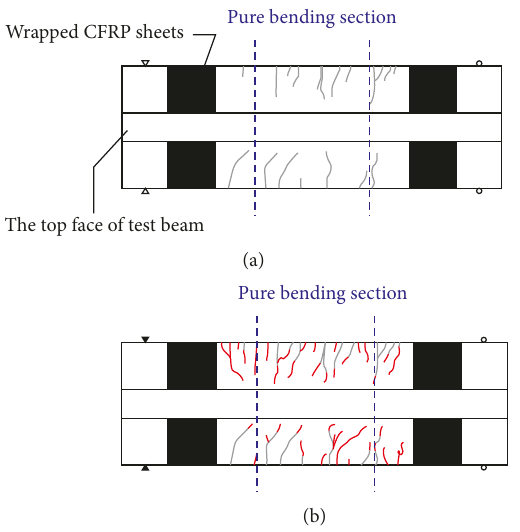
Figure 7: Cracking pattern observed experimentally (unfolded- drawing). (a) At instantaneous loading. (b) After time passage (200 d).